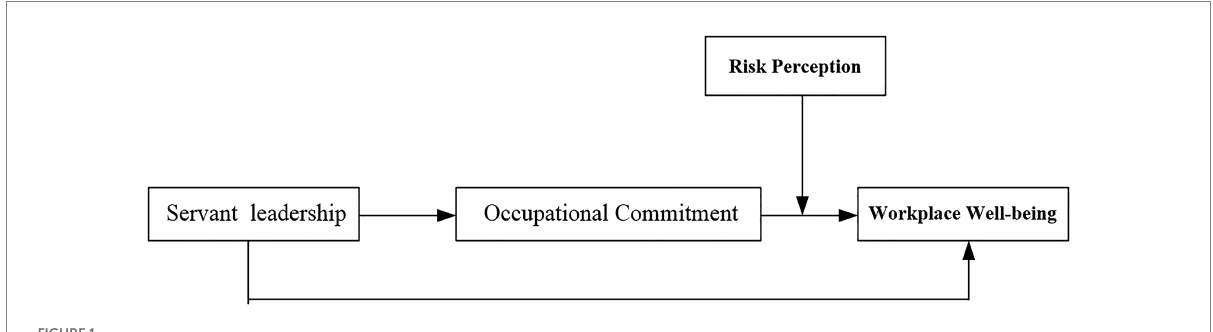
FIGURE 1 Theoretical